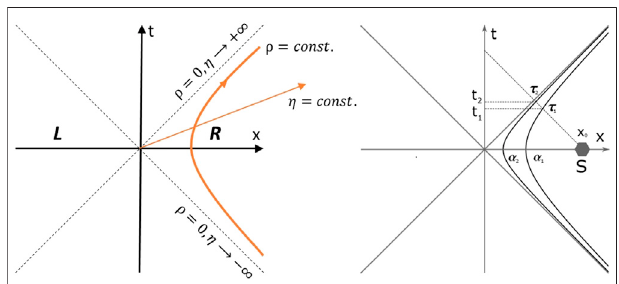
FIGURE 1 | Rindler observers. (Left panel) : Coordinate lines in the right (R) Rindler wedge of the Minkowski space. Coordinate lines of constant ρ are hyperbolasandthey correspond toworldlinesofRindlerobservers.Regions L and R, called the left and the right Rindler wedge, respectively, are causally disconnected due to the presence of the Rindler horizon t (cid:2) ± x . (Right panel) : Photon ’ s worldline intersects the Rindlers. A pair of Rindler observers in the R-wedge with different proper accelerations α 1 and α 2 , α < α 1 2 . A photon sent from the source S , located at t s intersects the worldlines of the Rindler observers at their respective proper times τ 1 and τ 2 . One can arrange things so that τ 1 (cid:2) τ 2